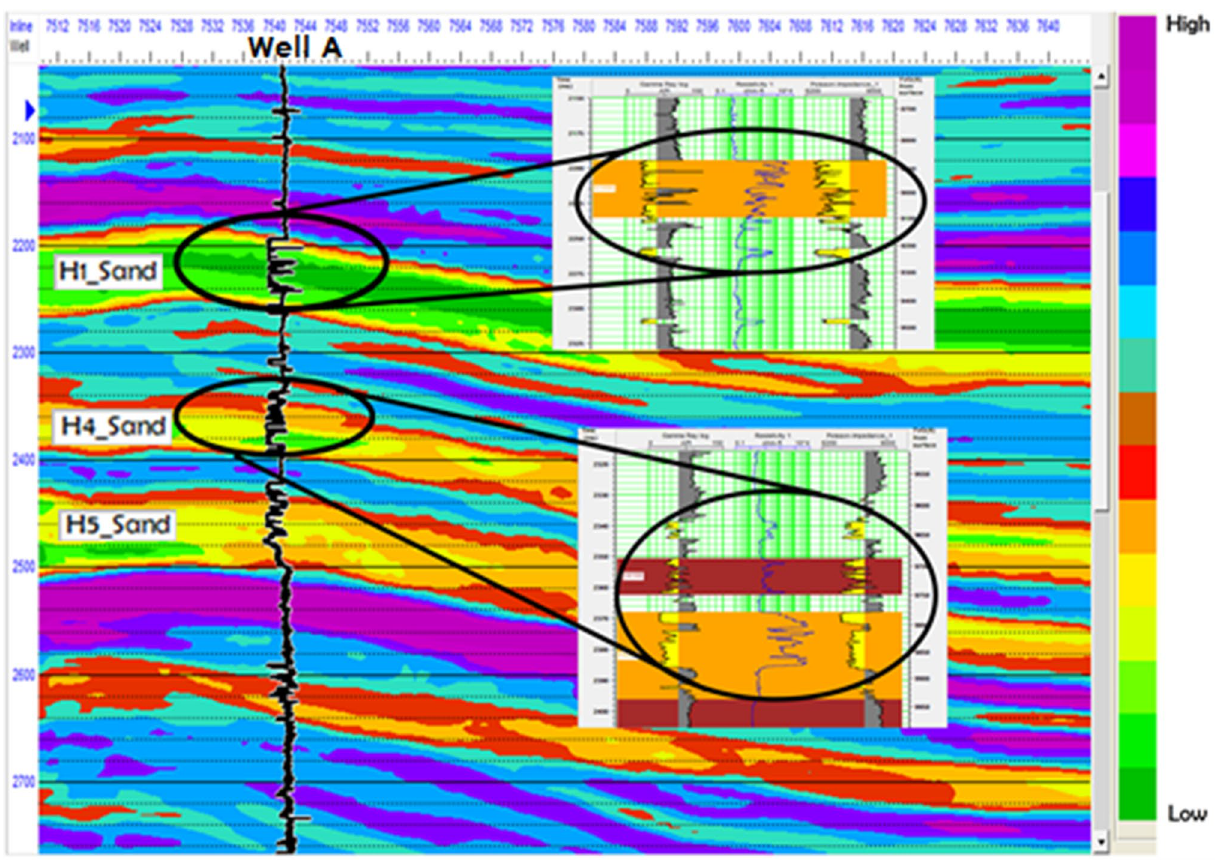
Fig. 9 Crossline section showing inverted Poisson impedance with gamma ray log (insert) over H1, H4 and H5_sands around well A. Note: low values of Poisson impedance correspond to good-quality hydrocarbon